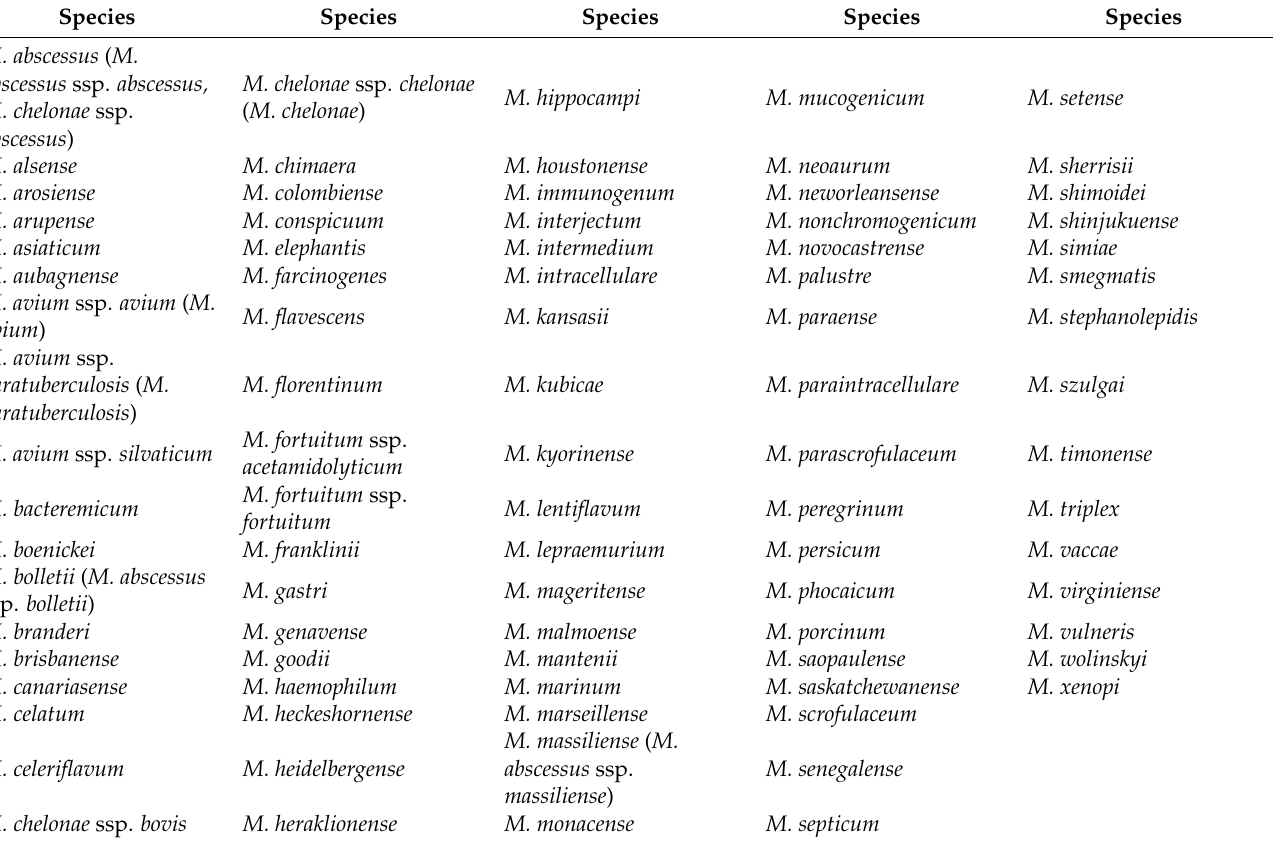
Table 5. Mycobacteria in Risk Group 2 according to European Union Directive 2000/54/EC [187]. Species Species Species Species